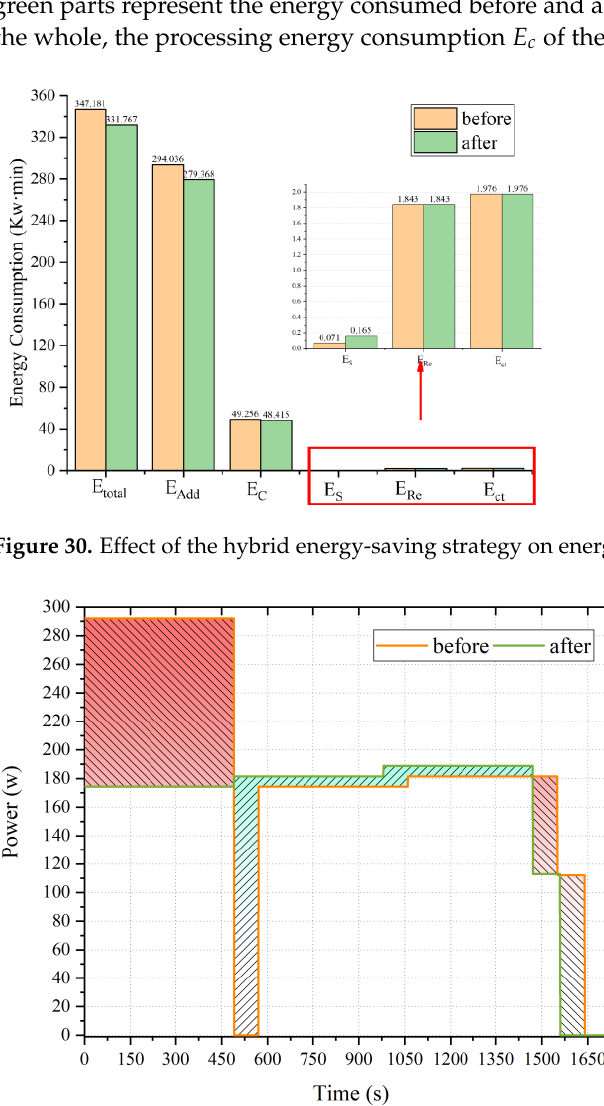
Figure 31. Power contrast curve of 𝑀 3 after adopting the hybrid energy-saving strategy.